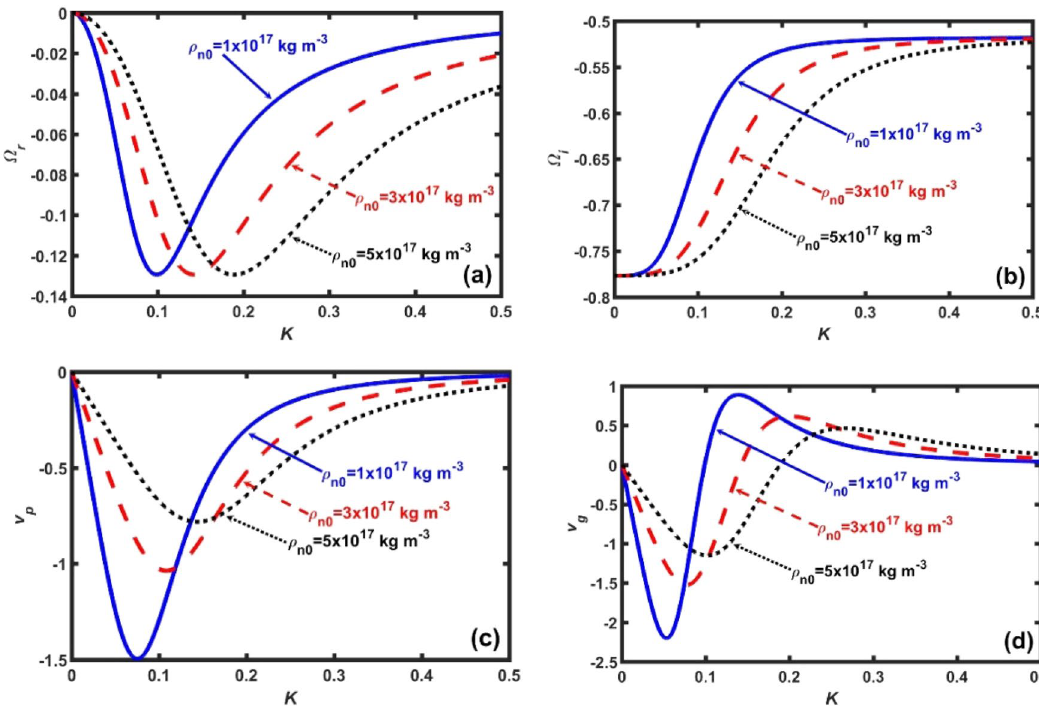
5 10 14 kg m −3 (fixed). The different lines link to = × 2 10 17 kg m −3 (red dash-dash line), and ρ n 0 = ×